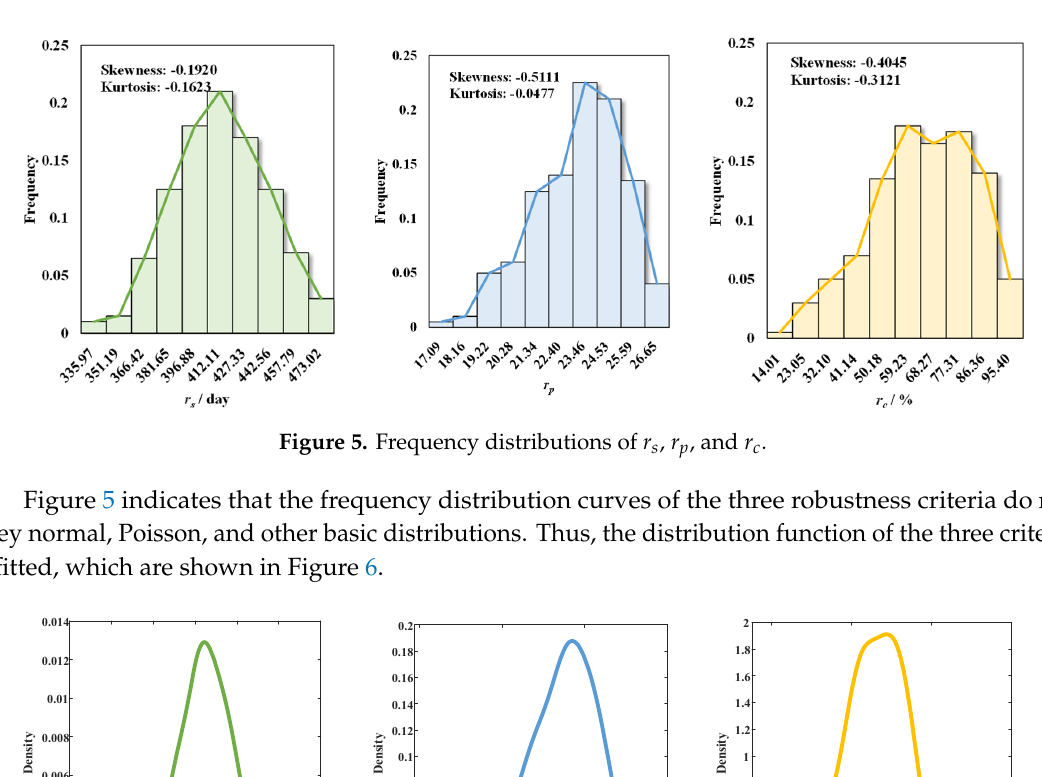
Table 3. Parameter estimation of the Copula function. r s , r p